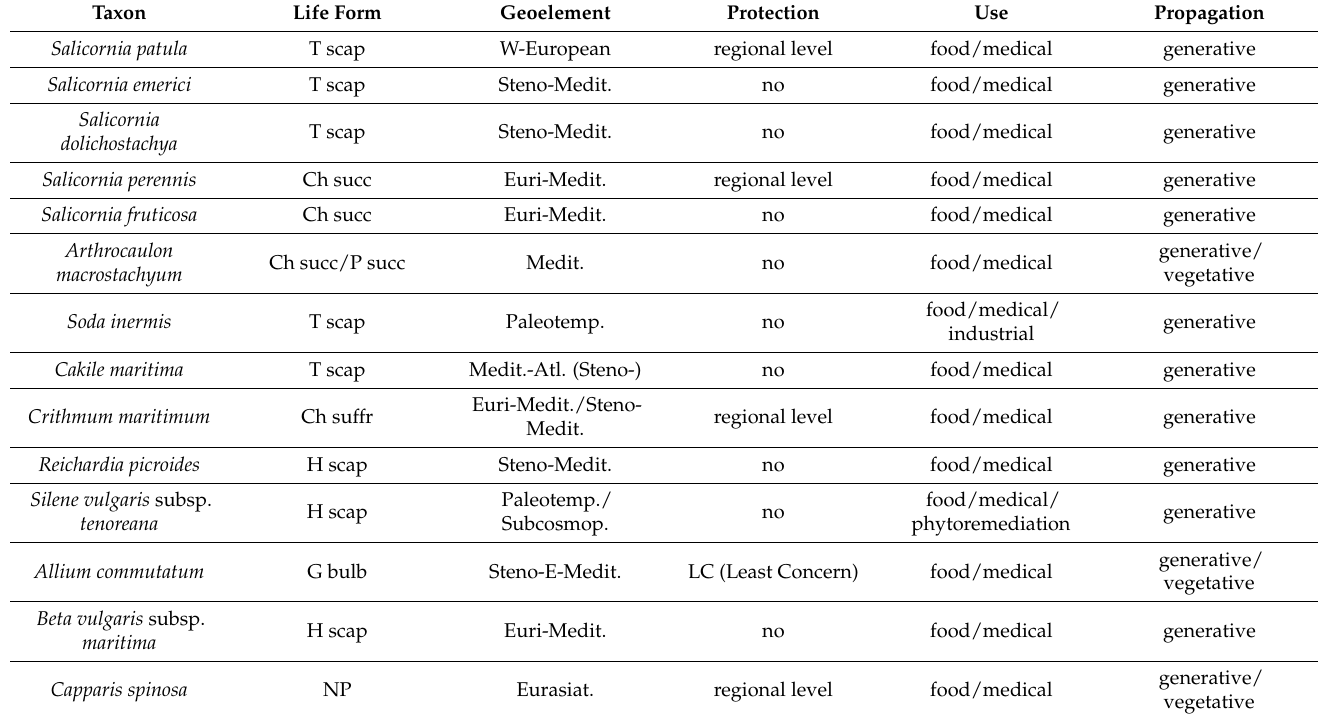
Figure 5. Salicornia sp. sold at a fish shop ( a ) and at a superstore ( b ) in Bari; a dish of pasta with Salicornia sp. (c; Peschici, Gargano, Northern Apulia). Table 1. Summary of the main features of the taxa considered in this